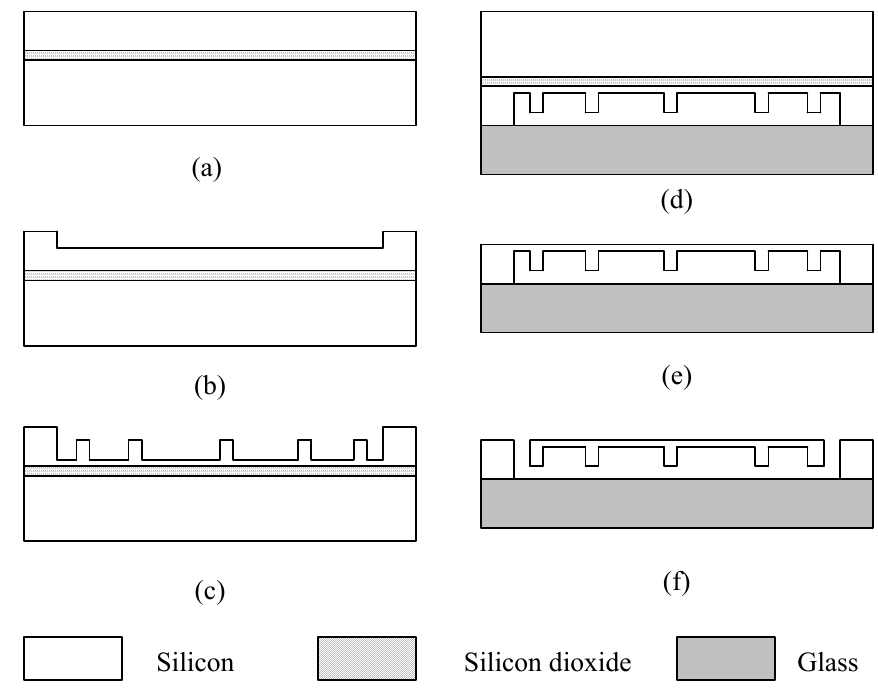
Figure 9. Schematic diagram of the fabrication